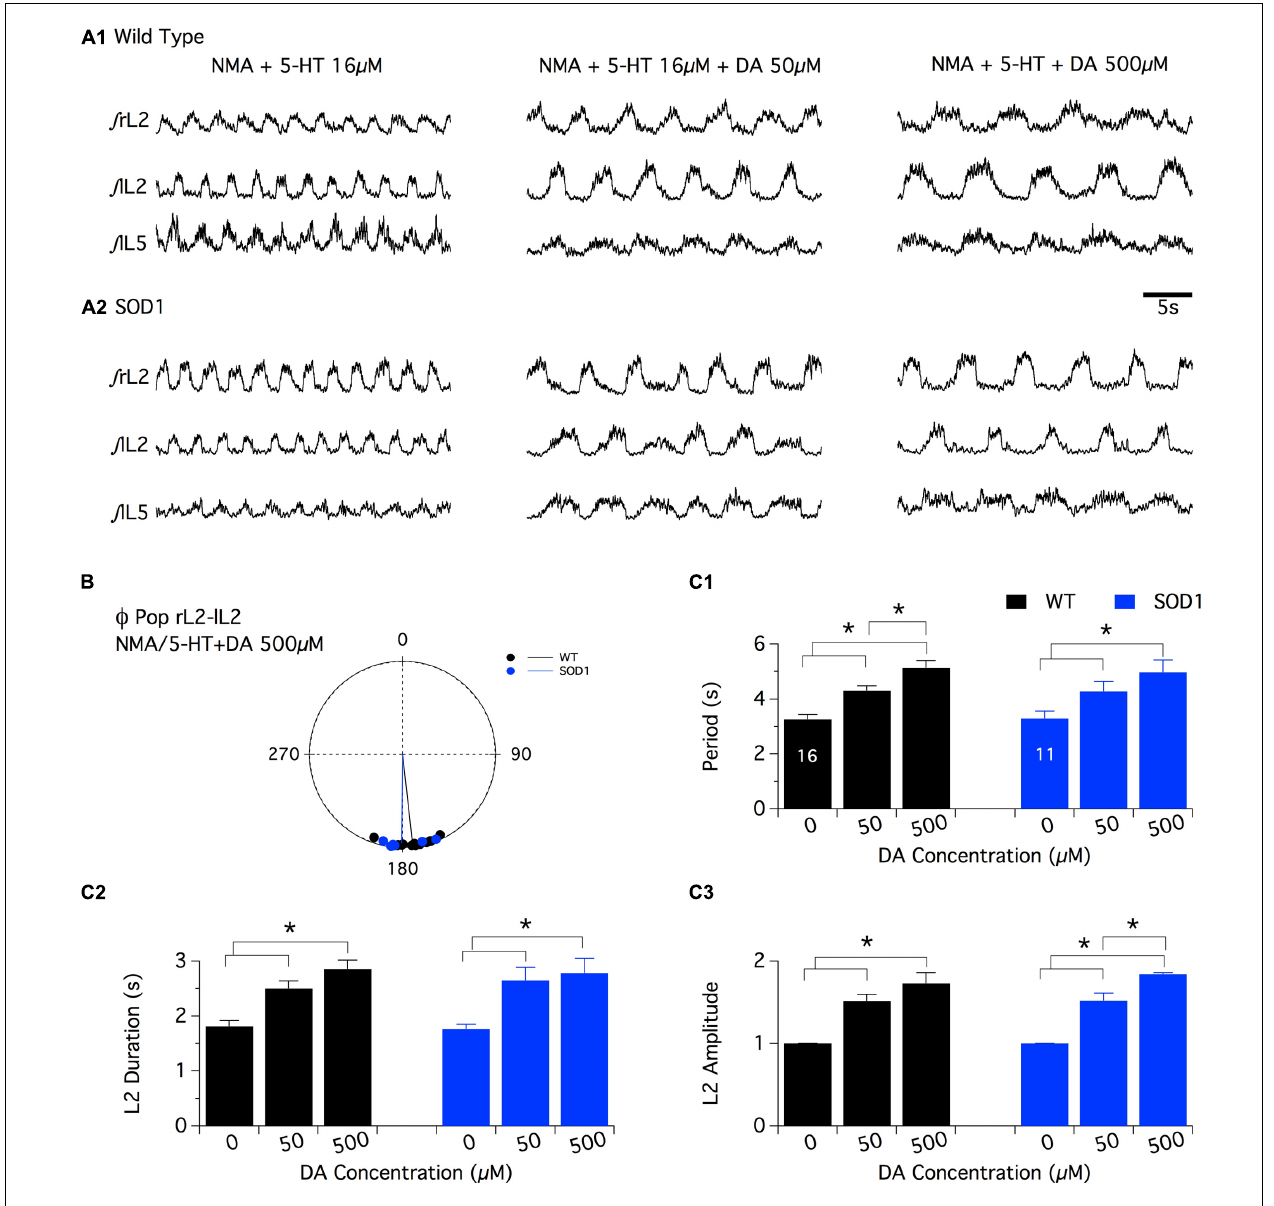
FIGURE 4 | Effects of dopamine on NMA + 5-HT-induced fictive locomotion in SOD1 and age-matched control mice. (A) Representative (cid:2) integrated ( ) traces of NMA + 5-HT (16 μ m each)-induced fictive locomotion recorded extracellularly from the right, left L2 and left L5 ventral roots (rL2, lL2, and lL5) in the absence or presence of dopamine (DA, 50 or 500 μ m). Upper panels present traces obtained in WT animals (A1) and lower panels in SOD1 mice (A2) . (B) Polar graph of the rL2-lL2 phase ( (cid:2) ) relationships computed in WT (black dots and line, n = 16) and SOD1 (blue